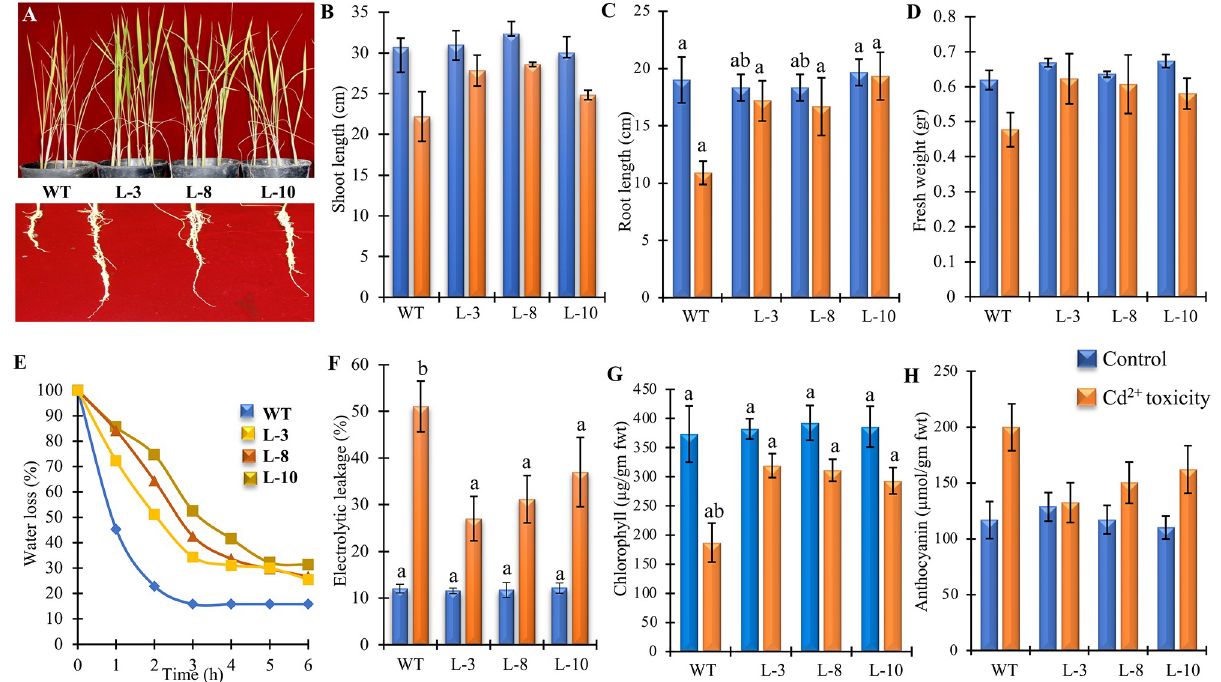
Fig 2. Morphological growth tolerance the ectopically expressed PgGPx transgenic rice plants under Cd 2+ stress. (A) Growth of seedlings and their root of transgenic as well as WT rice plants under 100 μ M CdCl 2 . Comparison of shoot length (B), root length (C), and fresh weight (D) of transgenic vis-a-vis WT plants under Cd 2+ toxicity showed that transgenic plants had better growth potential. Analysis of water loss (E) for 6h and cellular damage through electrolyte leakage (F) in response to exogenous Cd 2+ were measured. Total chlorophyll (G) and anthocyanin (H) contents were estimated from the transgenic and WT plants under control under stress conditions. Data represent as mean value ± standard deviation of three biological replicates (n = 3). Different letters above the bar showed significant difference between the treatments and plant genotypes (P < 0.05, ANOVA; post hoc